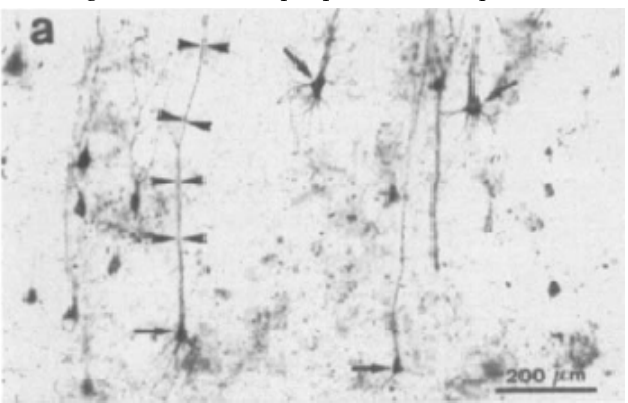
Figure 10. High-magnification photomicrographs showing a diffuse APP/A β -ir (immunoreactive) plaques in the frontal cortex of a 42-year-old female gorilla. Bar = 25 µ m. Reprinted from Neurobiology of Aging , 39, Perez S.E., Sherwood C.C., Cranfield M.R., Erwin J.M., Mudakikwa A., Hof P.R., Mufson